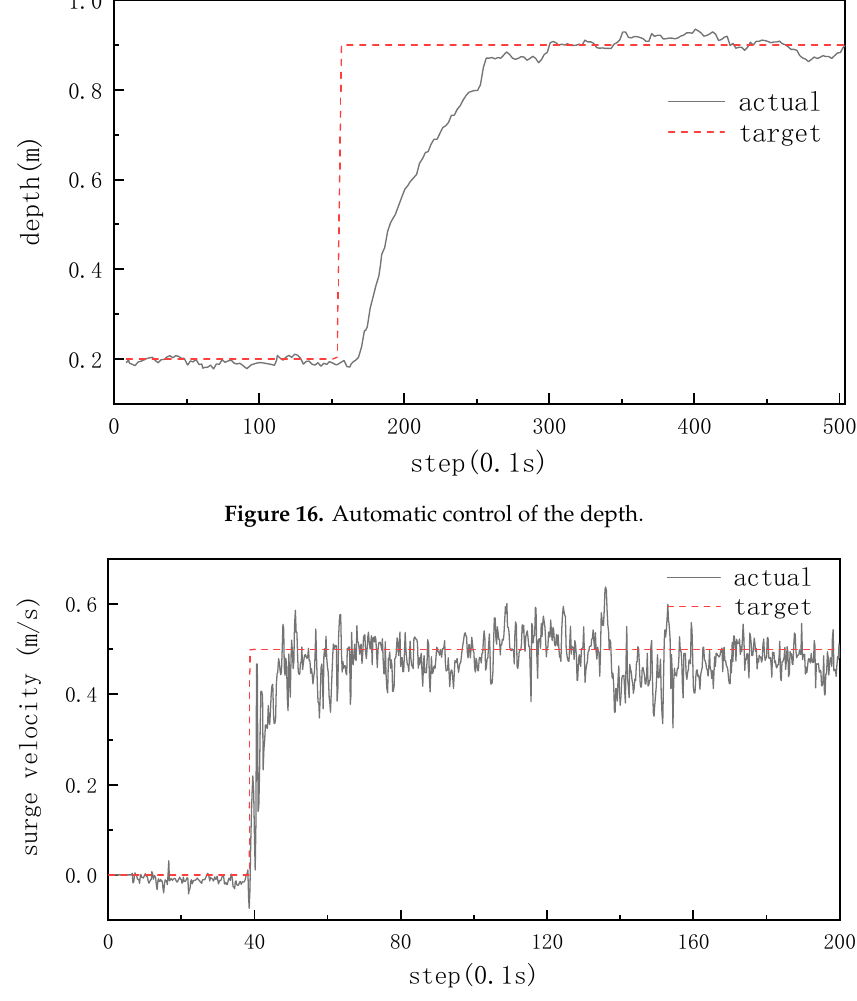
Figure 15. Automatic control of the heading.